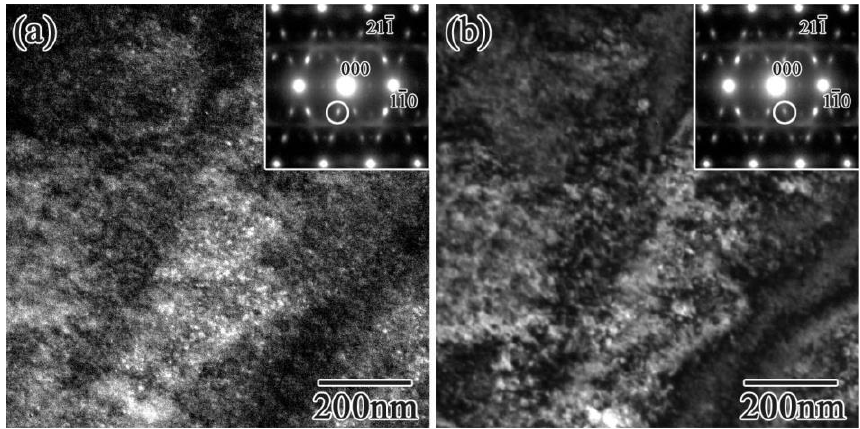
Figure 5. Dark-field images of Zr-14 at.% Nb alloy in ( a , b ), were observed by a circle in diffraction patterns in Figure 5a,b, respectively.